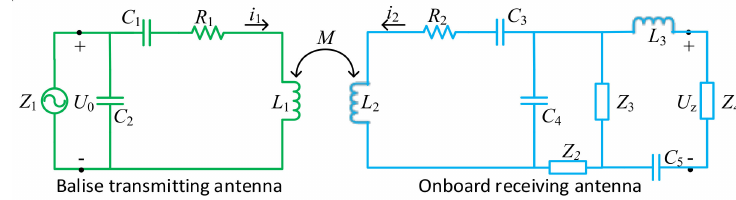
Figure 5. Equivalent circuit of uplink signal transmission